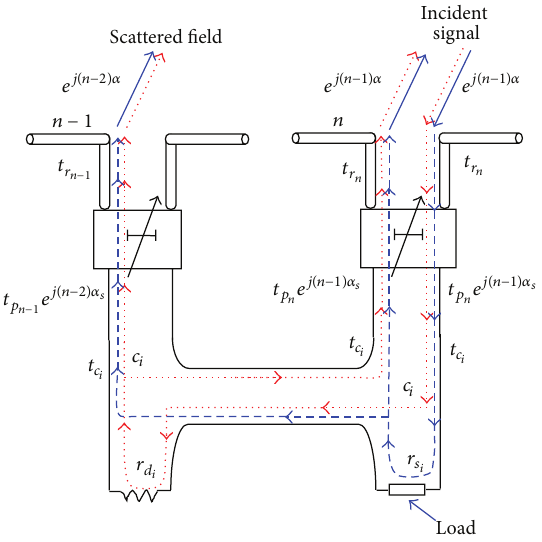
Figure 12: Signal paths through the first-level couplers in the parallel-feed network of a linear dipole array for 𝑛 th even-numbered element.